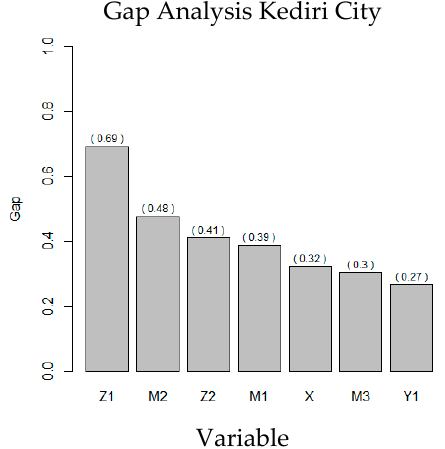
Figure A7. Bar Diagram of Gap Analysis of Kediri Regency.